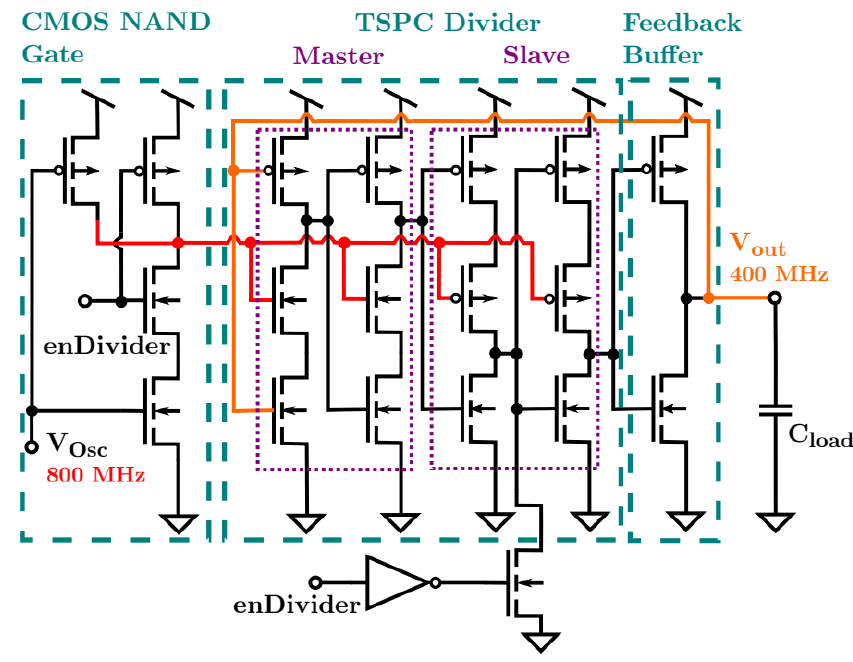
Figure 5. Dynamic divide by two frequency dividers with controlled input buffer.